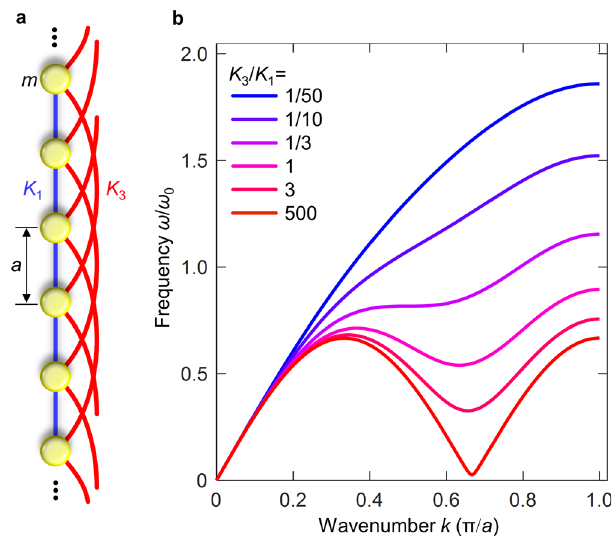
Fig. 2 One-dimensional toy model. a Masses m (yellow dots) are connected to their nearest neighbors separated by distance a by Hooke ’ s springs with spring constants K 1 (blue straight lines). In addition, all masses are connected to their N th-nearest neighbors at distance Na by springs with Hooke ’ s spring constants K N (red curved lines). As an example, we choose N ¼ 3. For K ≠ 0, the spatial period of this arrangement is a . Hence, the 1 fi rst Brillouin zone is given by wavenumber k j j (cid:6) π = a . b Dispersion relation ω k ð Þ ¼ ω ð(cid:2) k Þ . The differently colored curves (see legend) represent different ratios of the spring constants K 3 = K 1 , increasing from top to ffiffiffiffiffiffiffiffiffiffiffiffiffiffiffiffiffiffiffiffiffiffiffiffiffiffiffiffiffiffiffi q bottom. For clarity, we fi x the phase velocity in the long-wavelength limit k ! 0, i.e., v ¼ a ð K þ K N 2 Þ = m ¼ const ¼ a ω N ph 1 0